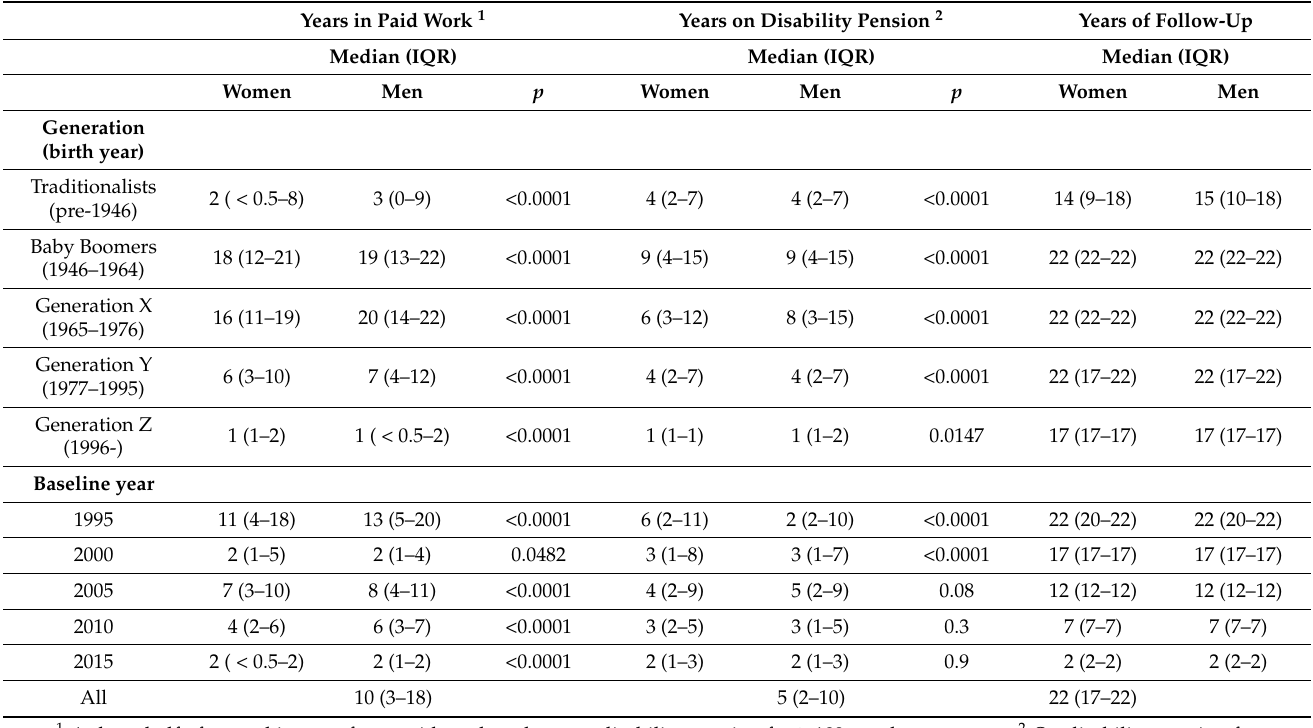
Figure 1. Work participation across the life course, among women and men aged 19–69 in Sweden from 1995–2015. Table 2. Person-years in paid work and on disability pension, with length of follow-up, among women and men aged 19–69 in Sweden from 1995–2015.